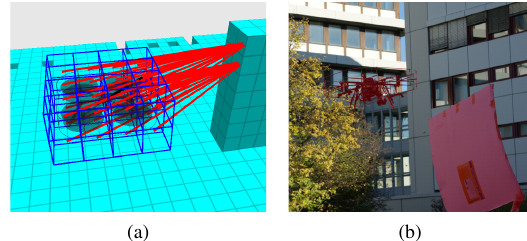
Figure 10: Visualization of a 3D grid map and repelling forces induced by obstacles in range (a) and a photo (b) taken during an experiment where the hovering UAV avoided collisions with a dynamic obstacle approaching the vehicle (UAV and obstacle colorized for better